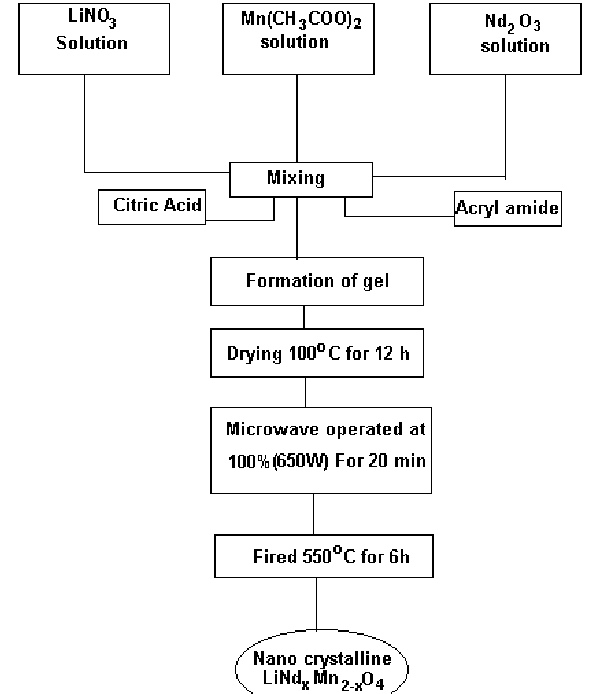
Figure 1. Flow chart for the preparation of cathode materials by CAM microwave assisted sol-gel